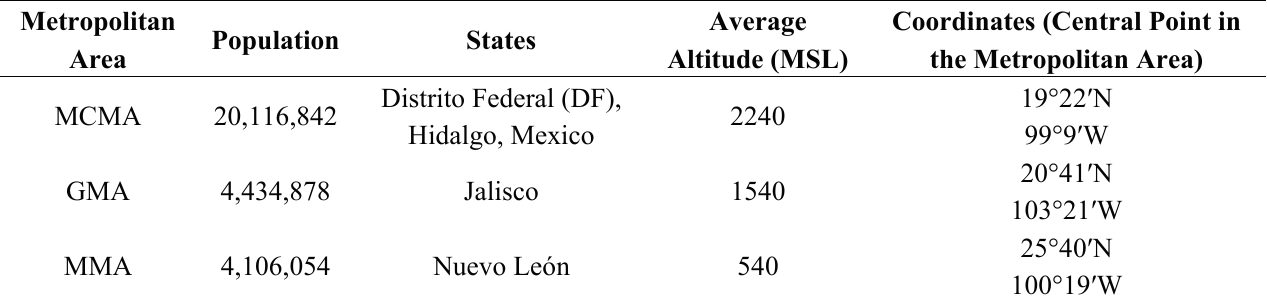
Table 1. Major characteristics of the study areas a